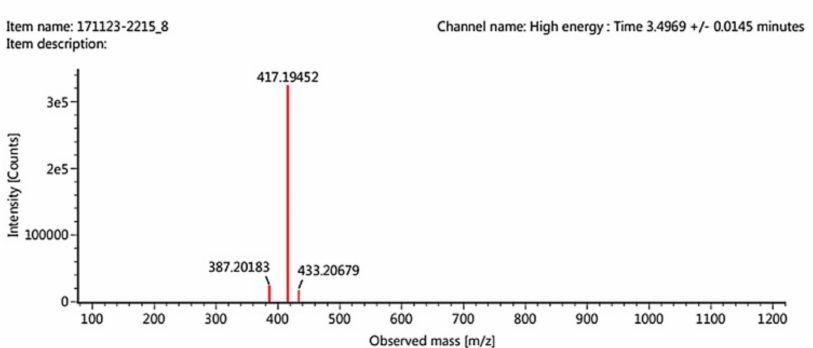
Figure 5. Liquid chromatography tandem mass spectrometry (LCMS-MS) mass spectra.